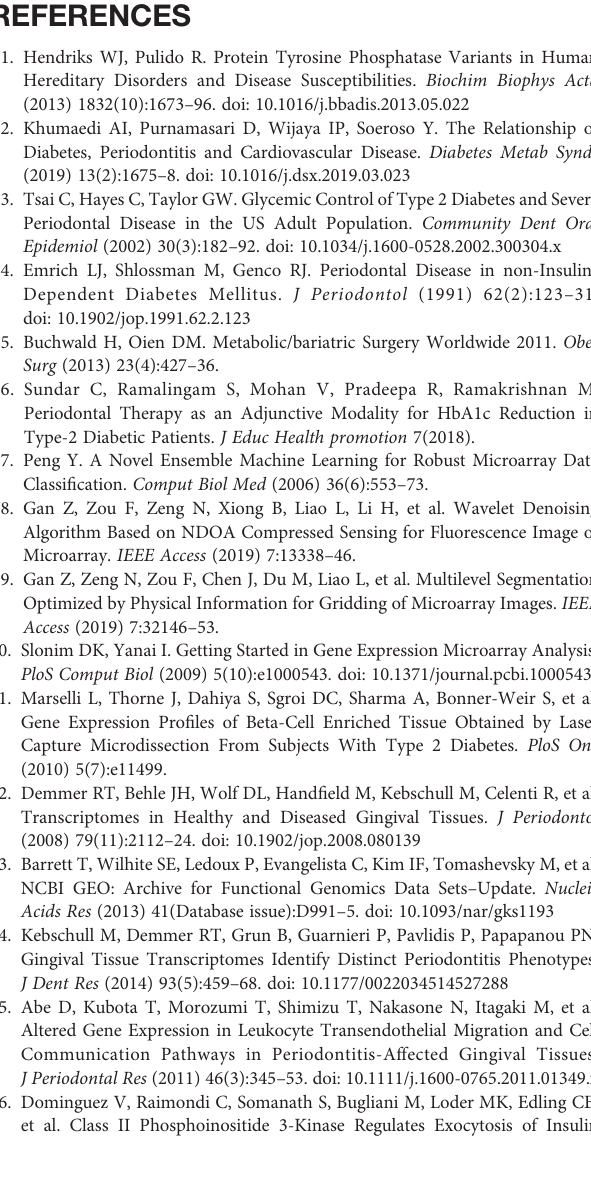
Supplementary Figure 1 | The results of GO analysis using common DEGs. The colorofthe dotsindicatesthep-value andsizeisthenumberofincludedgenes.The meaning of the dot color is as follows: red: adjusted p-value < 0.002, purple: < 0.004, blue < 0.008. (A) upregulated genes (B) downregulated genes